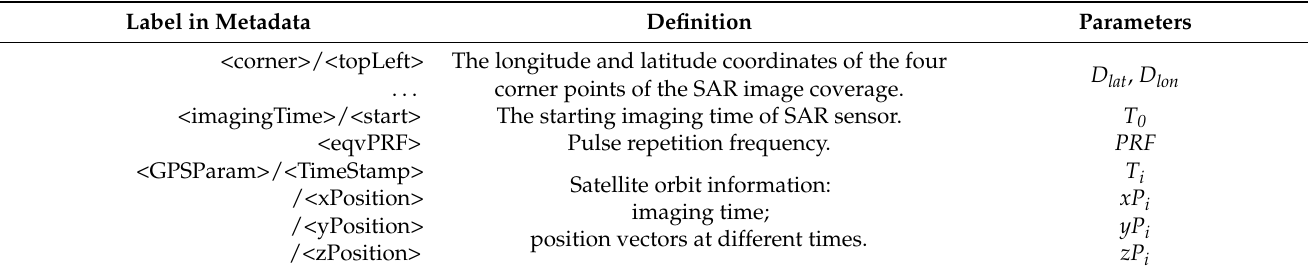
Table 1. The imaging parameters in GF-3 metadata required for calculation of local geometry angles based on RPC